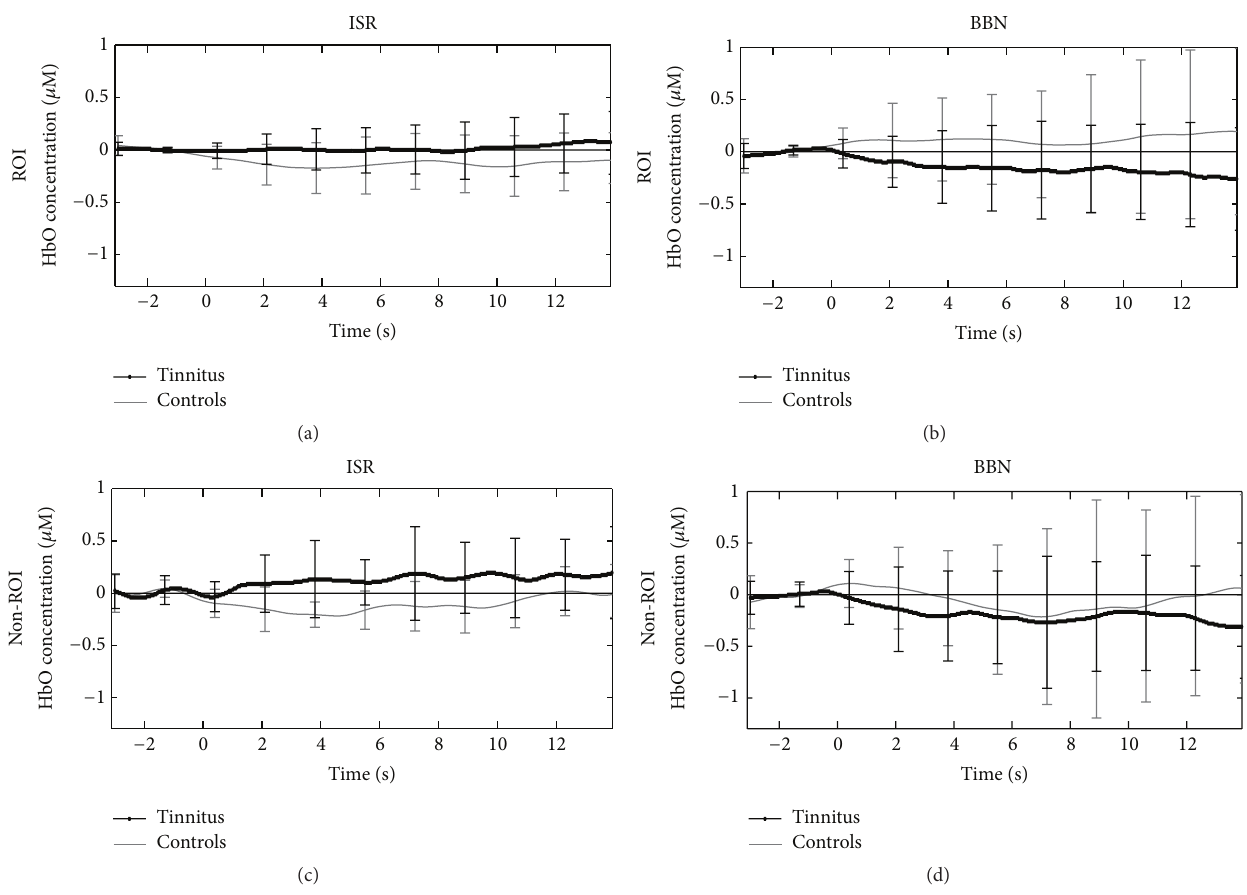
Figure 4: Mean oxy-hemoglobin (HbO) concentration traces versus time (seconds) from ROI and non-ROI under conditions of silence (interstimulus rest; ISR) and stimulation (broadband noise; BBN) between tinnitus and control groups. The unit of concentration is micromolar ( 𝜇 M). Standard deviations at each time point of the traces were calculated using the equation: 𝜎 = √(Σ(𝑎 − 𝑎) 2 )/𝑁 with 𝜎 = standard deviation; 𝑎 = each value in the population; 𝑎 = the mean of the values; 𝑁 = the number of values. The figure represents brain activity during the 4–18-second time period in the respective testing paradigm. In the figure, 0 corresponds to 4 seconds of the 18sec period. Left hand column demonstrates maintained or increased HbO concentrations in tinnitus participants (dark lines) relative to control (gray lines) in both ROI (a) and non-ROI (c) under conditions of silence (ISR). Note the deactivation in controls in both regions during ISR. Right hand column demonstrates the effects of BBN on HbO concentration in ROI (b) and non-ROI (d) in both groups. Note the robust suppression of HbO in tinnitus in response to BBN that continues throughout the recording block ((b) compared to (a)) with the as expected increases in control HbO indicative of auditory stimulation in the intact circuit. BBN also suppresses HbO in non-ROI ((d) compared to (c)) that is also maintained across the recording block suggesting residual inhibition in nonauditory cortical regions in tinnitus subjects. All traces are marked with standard errors calculated for the 4 channels (2 on the right and 2 on the left for both ROI and